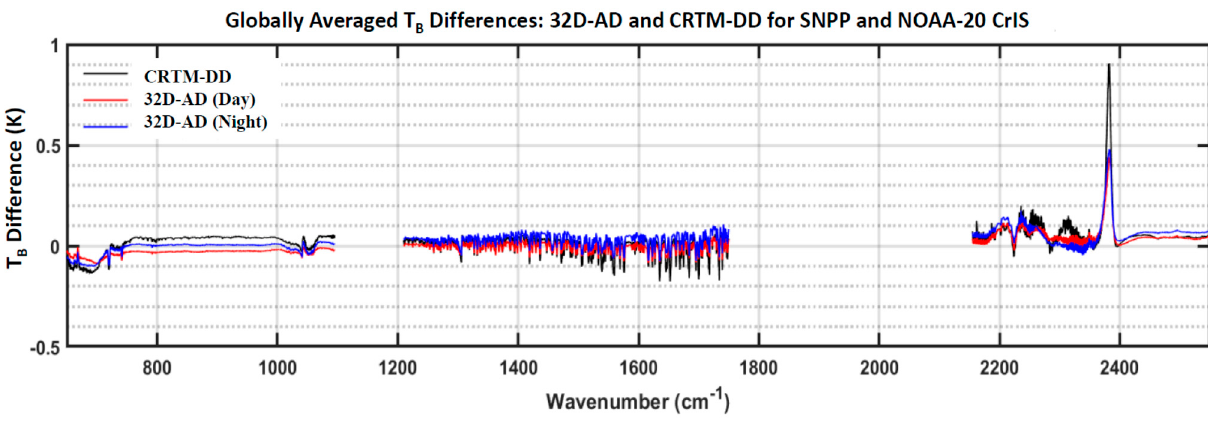
Figure 10. Comparison of the SNPP and NOAA-20 CrIS inter-sensor calibration radiometric biases at 2211 channels spanning wavenumbers from 650 to 2545 cm − 1 using the methods of 32D-AD and RTM-DD, where the data cover the period from September 27, to October 28, 2019.